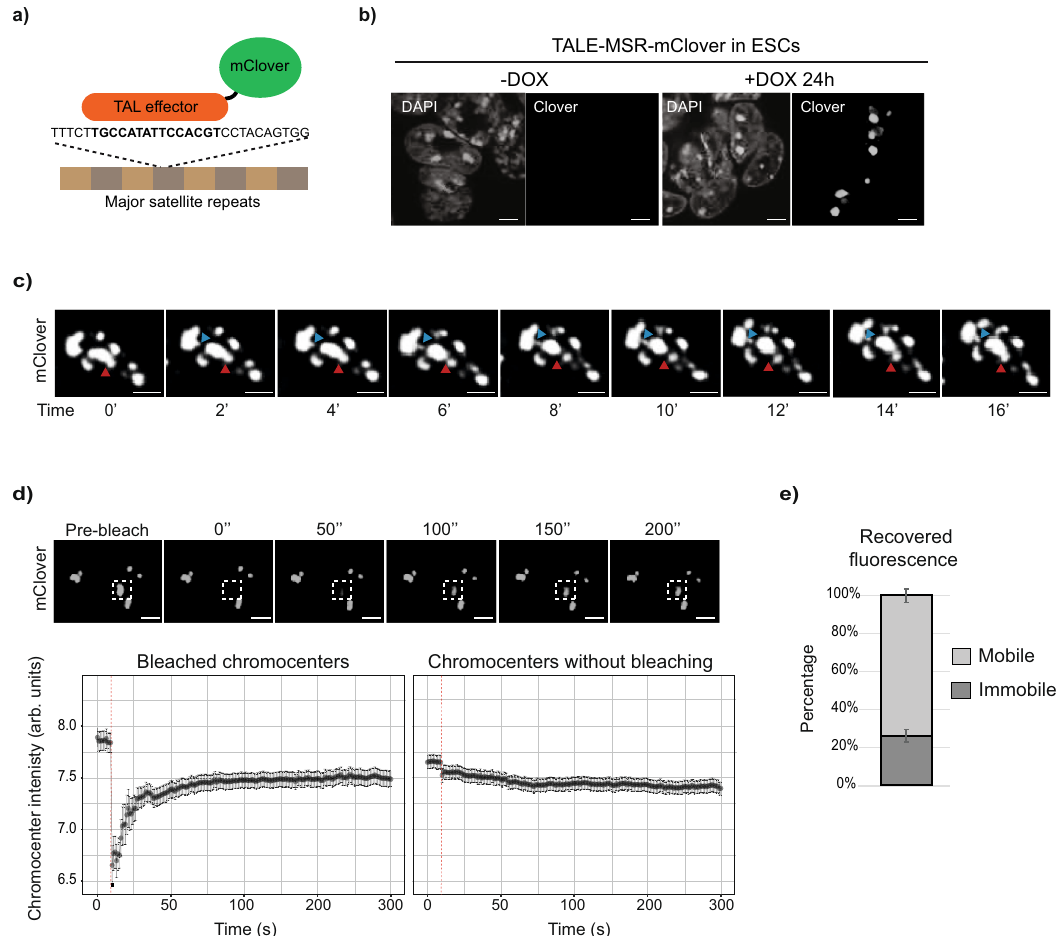
Fig. 1 Constitutive heterochromatin forms liquid-like condensates in embryonic stem cells. a Schematic showing the recruitment of doxycycline- inducible TALE-mClover to MSR DNA to enable live-cell visualisation of chromocenter dynamics. b Representative images from >10 independent experiments showing the TALE-MSR-mClover signal and DAPI counterstain in ESCs without and with doxycycline induction. Scale bars, 5 μ m. c Time-lapse microscopy experiment in doxycycline-induced TALE-MSR-mClover ESCs. Projections of an ESC nucleus over time reveal the ability of mClover-labelled chromocenters to separate and coalesce (red arrow) and to form protrusions (blue arrow). Scale bars, 5 μ m. d Quanti fi cation of fl uorescence recovery after photo-bleaching individual chromocenters. Top panel shows representative images of the FRAP experiment; the dashed squares indicate the photo- bleached region. Lower panel shows the recovery of the mClover signal (not normalised, log 2 median intensity ± SEM) over time at either bleached (left) or unbleached (right) chromocenters. Data represents n = 63 photo-bleached chromocenters, collected at least from N = 3 independent photo-bleaching experiments and the red dashed line shows the bleaching event. Scale bars, 10 μ m. e Histogram depicting the percentage± SEM of mobile and immobile components of chromocenters ( n = 47 chromocenters), as calculated from the end-value of the recovered fl uorescence intensity. See also Supplementary Fig. 1 and Supplementary Movies 1, 2a, 2b, 2c, 2d, 3, 4 and